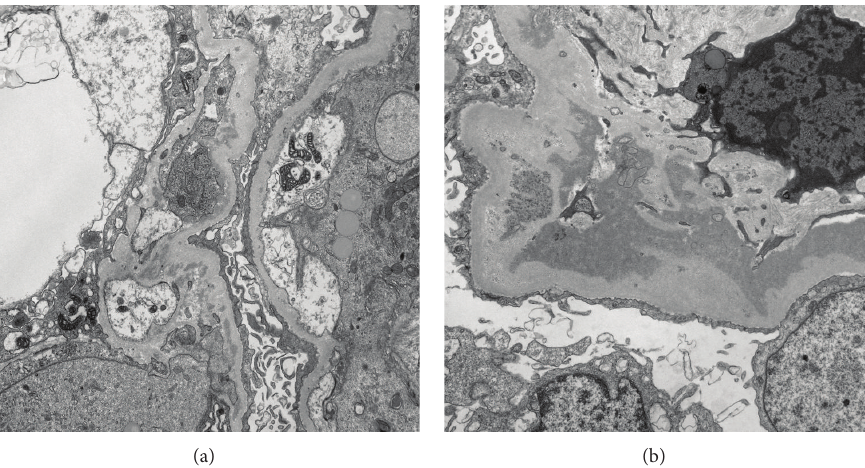
Figure 4: Electron microscopic finding of kidney biopsy. Electron microscopy demonstrates diffuse podocyte foot process effacement, proliferation in the capillary loop, and remodeling of the glomerular basement membrane with cellular interposition (a). The glomerular basement membrane is markedly irregular in thickness, and dense deposits are located in the mesangial areas and focally within subendothelial space without any organized substructural features (b). In loops without these abnormalities, the glomerular basement membrane is of normal thickness and has normal architecture.